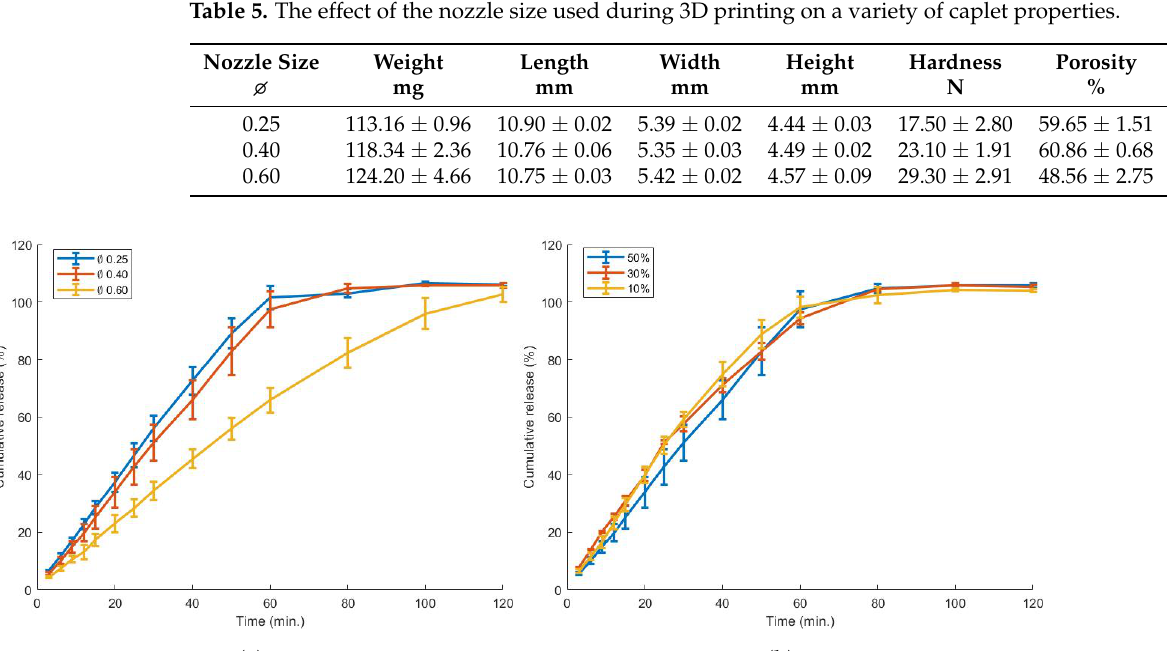
0.60 mm has (cid:31)